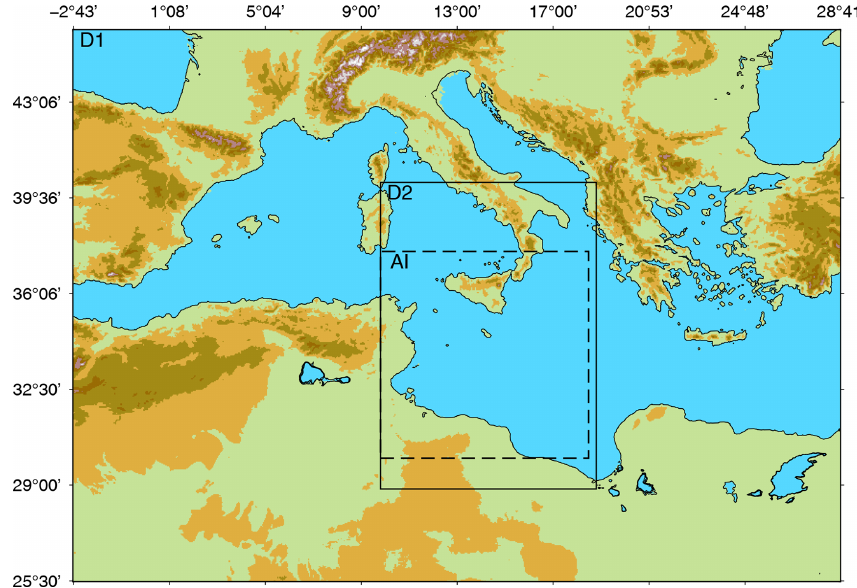
Figure 2. Map of the large-scale domain D1, with the domain D2 indicated by the solid-line frame and the area of interest (AI) indicated by the dashed-line